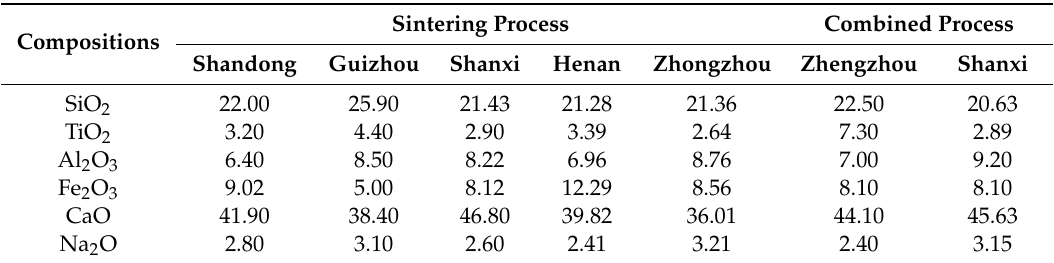
Table 2. Main chemical compositions of RM from sintering process and combined process in di ff erent regions in China (%, w / w )